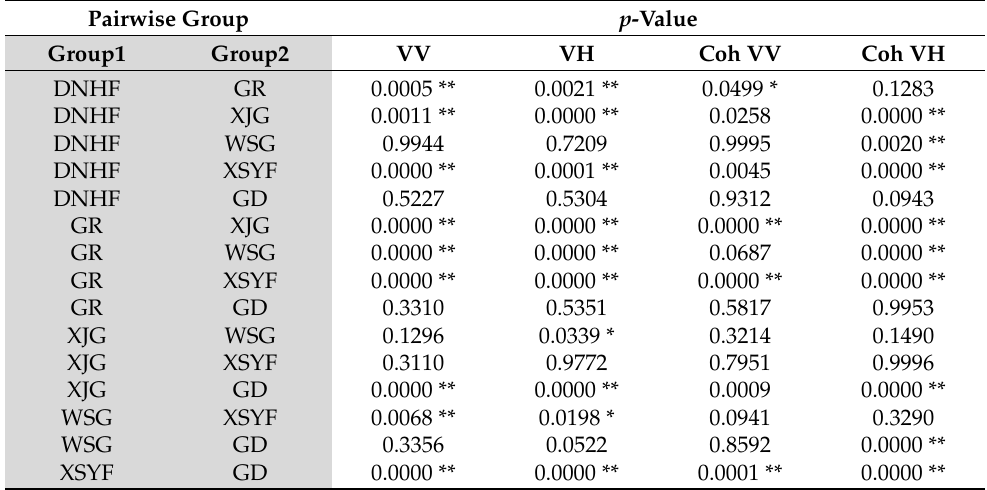
Table 3. Results of Tukey’s HSD test. * and ** represent the statistical variances at 95% and 99% confidence levels.